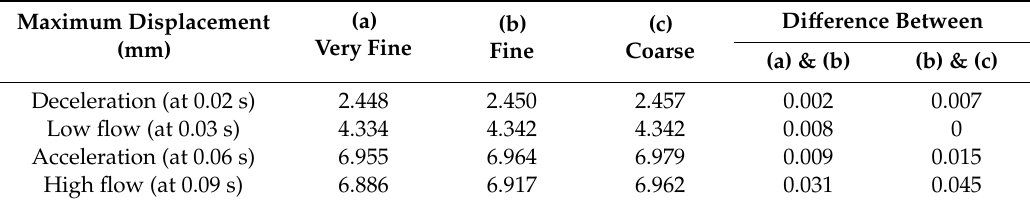
Table 1. Maximum mesh displacement with di ff erent mesh sizes.